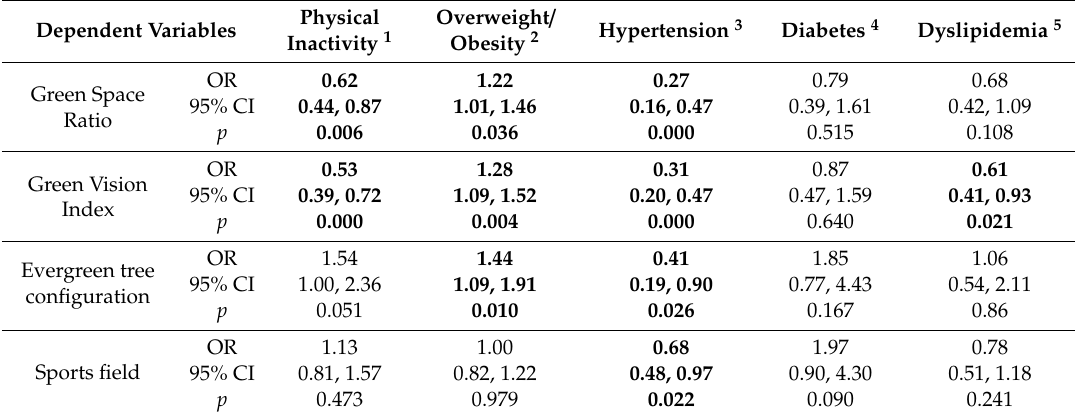
Table 3. Logistic regression analysis of the odds of CVD risk factors by characteristics of green space. Dependent Variables